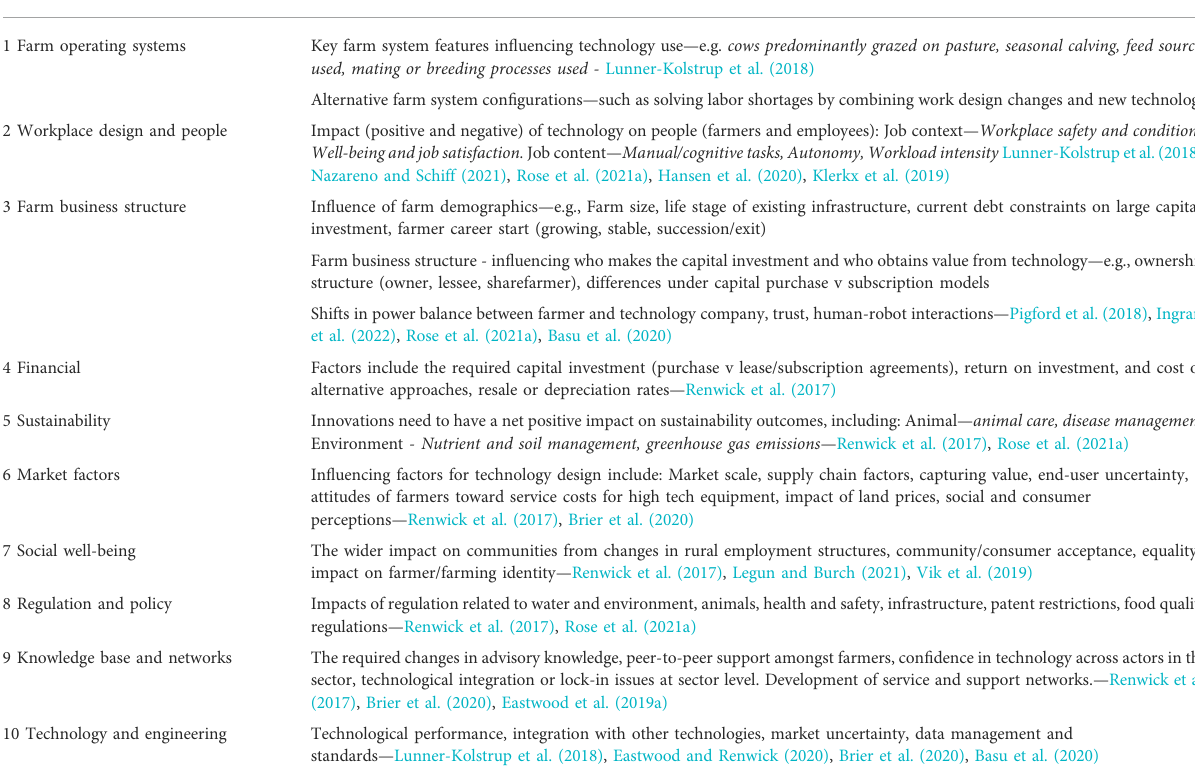
TABLE 1 Proposed design guide and considerations for responsible research and innovation into robotics and automation in smart farming.